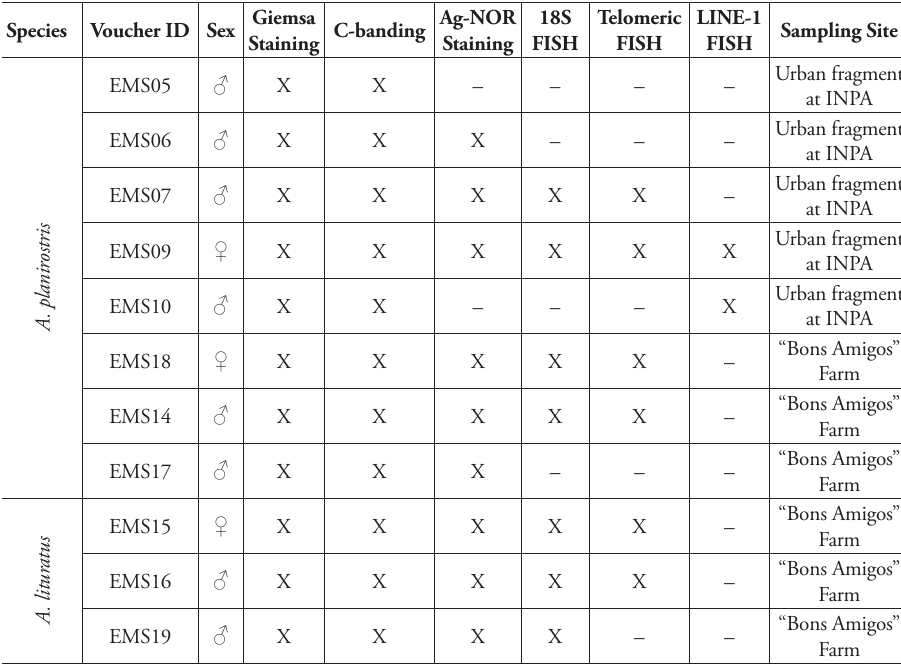
Table 1. List of specimens and respective methodologies applied in the present study. Sampling localities for each voucher are given in the last